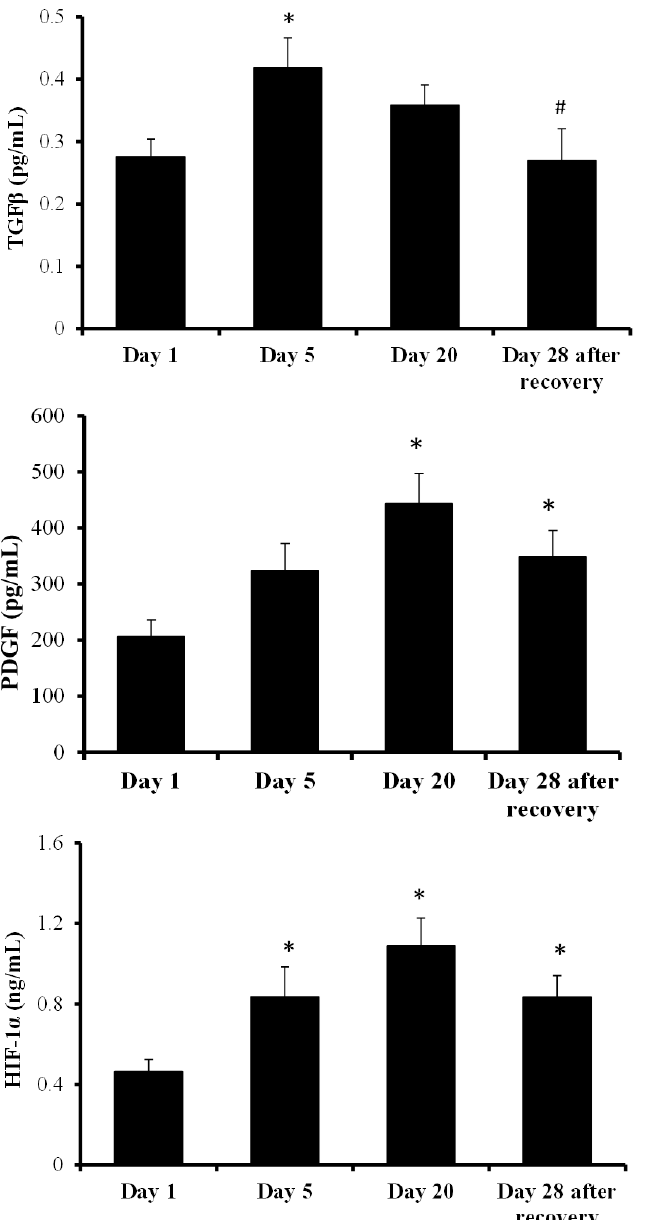
Figure 2. TGF β , PDGF and HIF-1 α plasma levels following HBOT sessions 1, 5, 20 and 28 (days) after wound recovery. The effects of the HBOT sessions were evaluated by a one-way ANOVA. p < 0.05; * indicates significant differences with respect to session 1; # indicates significant differences with respect to session 5. Abbreviations: TGF β , transforming growth factor beta; PDGF, platelet-derived growth factor; HIF-1 α , hypoxia-inducible factor